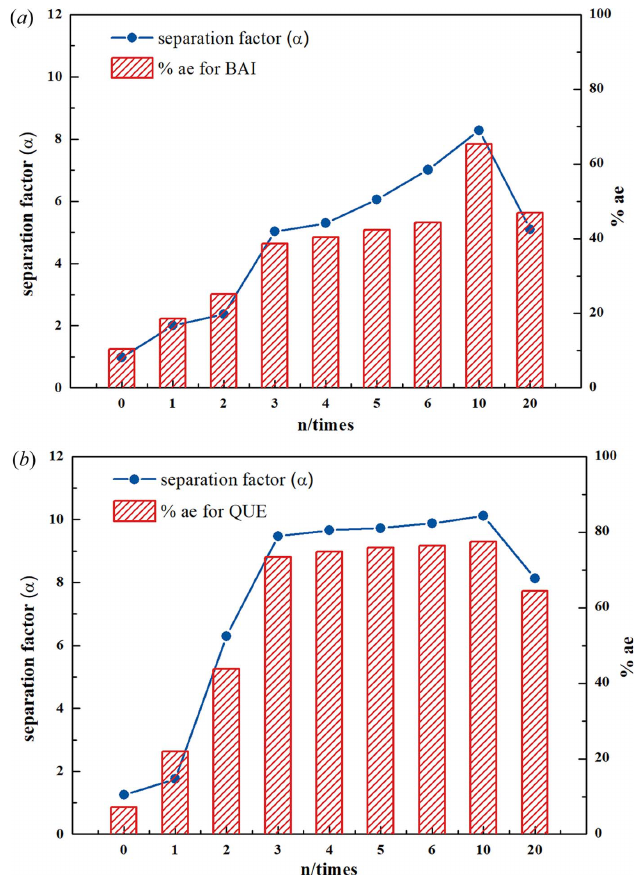
Figure 6 Variations in separation factor and %ae with respect to the amounts of solvent: ( a ) BQC system, ( b ) QMC system.